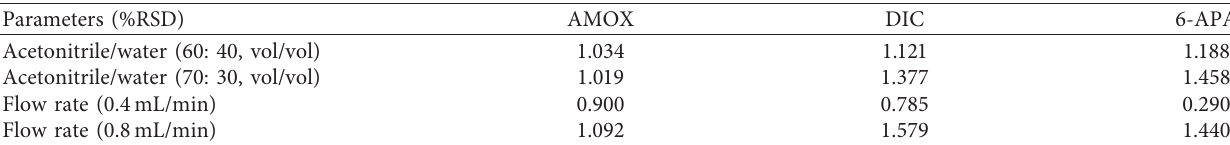
Table 4: Experimental results of robustness for the determination of AMOX and DIC with their common impurity, 6-APA, by the proposed HPLC/MS